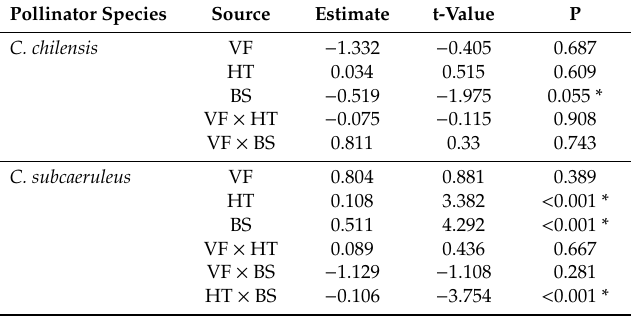
Table 2. Generalized lineal model of the e ff ect of pollinators’ functional traits on pure Calceolaria pollen load for both study species. VF = visitation frequency; HT = handling time; BS = body size. Asterisks represent statistical